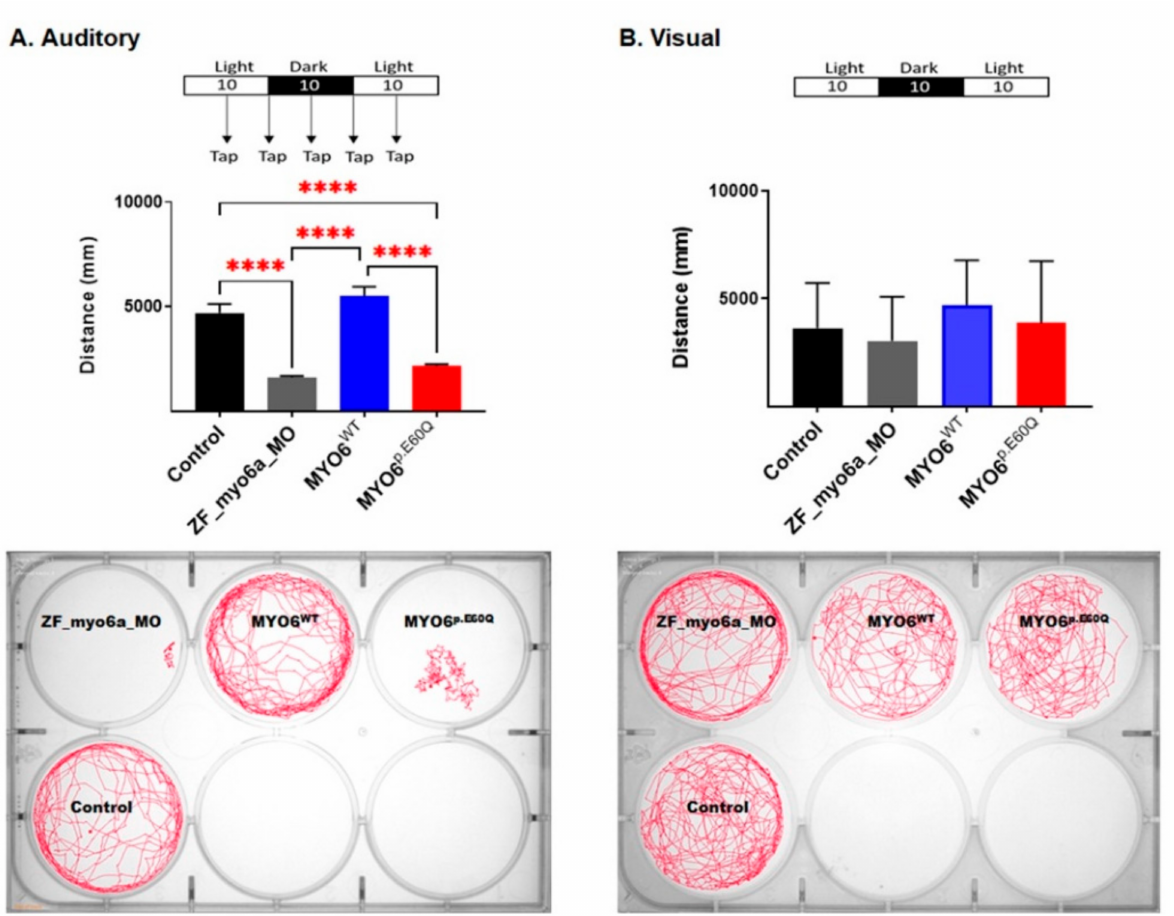
Figure 6. Auditory-sensory behavioral response in zebrafish larvae was examined by assessing locomotive behavior recorded through the presentation of light–dark cycles over time intervals of 30 min and tapping. The total distance moved by zebrafish larvae was calculated using Ethovision software (Noldus). ( A ). Auditory-sensory behavioral response. ( B ). Visual-sensory behavioral response. Representative behavior and response activity to auditory-sensory stimuli of zebrafish groups measuring movements over time for the examined zebrafish groups; movement is shown by the drawn red lines. The number of experiments n = 4; values represent mean with standard deviation. Statistical analysis was performed with one-way ANOVA followed by Tukey’s multiple tests for multiple comparisons, **** p <